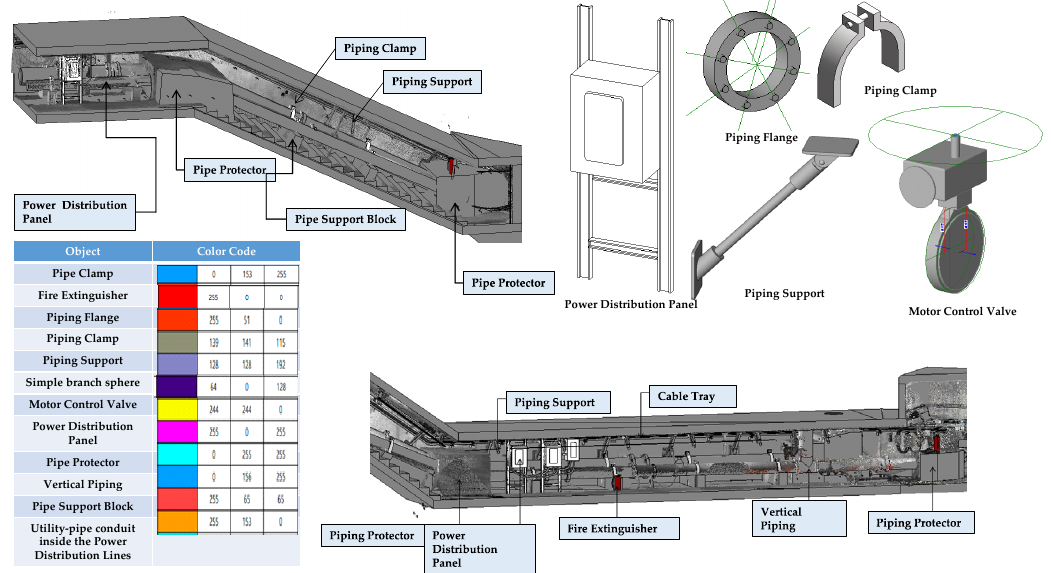
Figure 6. Color code